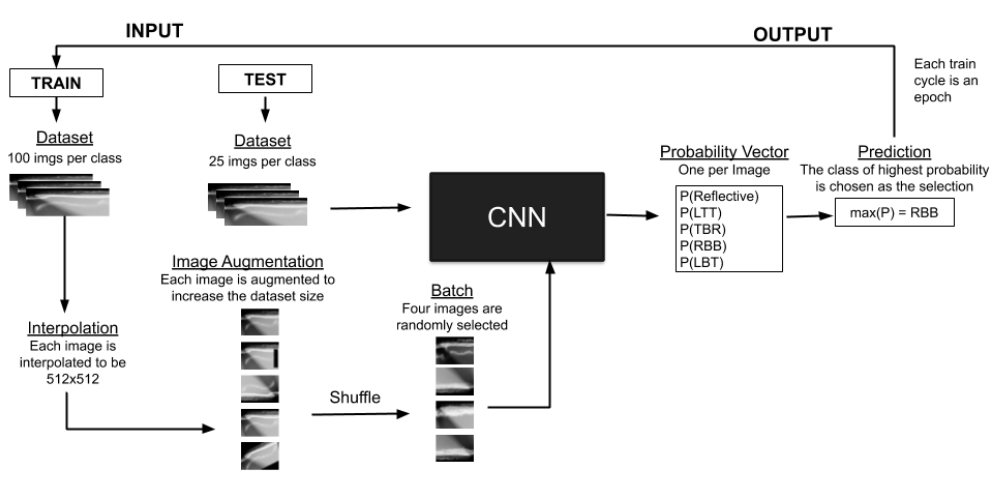
Figure 3. The work flow for one training epoch and testing cycle. Each epoch of the training process results in an update of the CNN